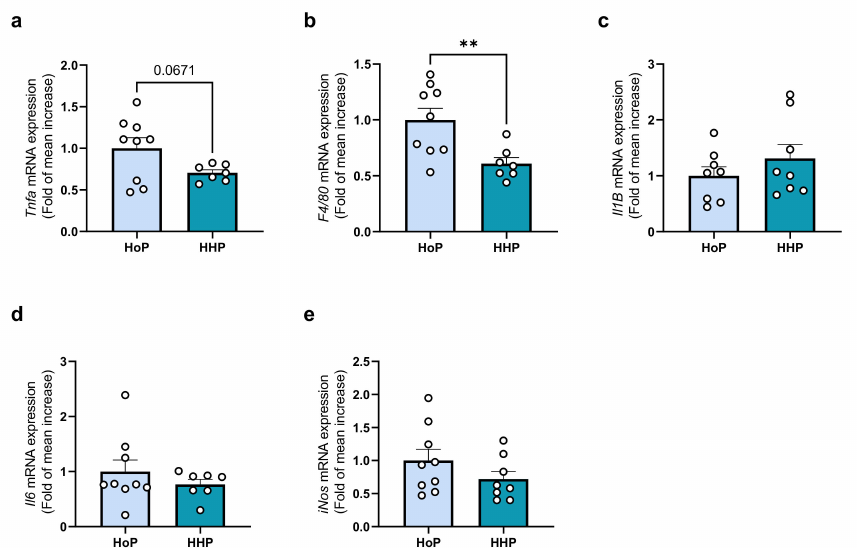
Figure 5. Inflammatory markers in the liver following a 7 days gavage of mice with HoP or HHP. ( a ) Tnf α (TNF α ), ( b ) F4/80 (F4/80), ( c ) Il1 β (IL1 β ), ( d ) Il6 (IL6), ( e ) iNos (iNOS). n = 9 in each group, ** p <